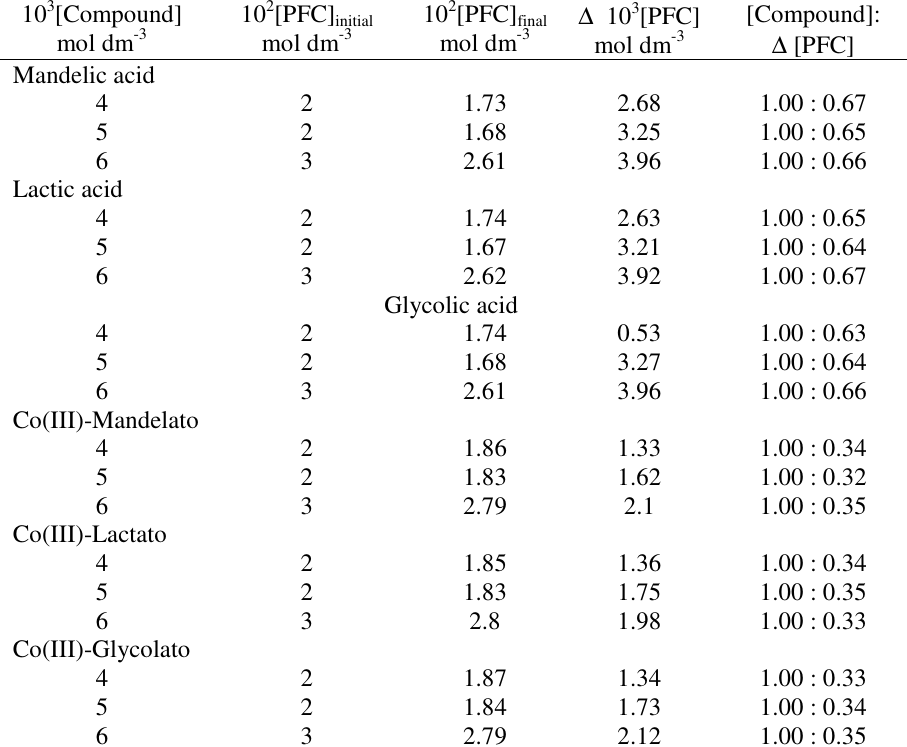
Table 2. Stoichiometric data for PFC oxidation of Co(III) bound and unbound α -hydroxy acids in presence of CTAB at 35±0.2 0